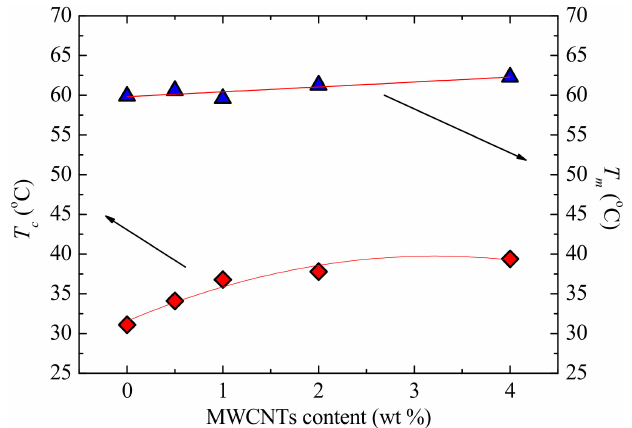
Figure 13. DSC crystallization and second heating melting temperatures as a function of MWCNT content for neat PCL and the PCL/(PC/MWCNT) nanocomposites. A linear fit and a polynomial fit for the experimental data of T m and T c , respectively, are used to guide the eye.